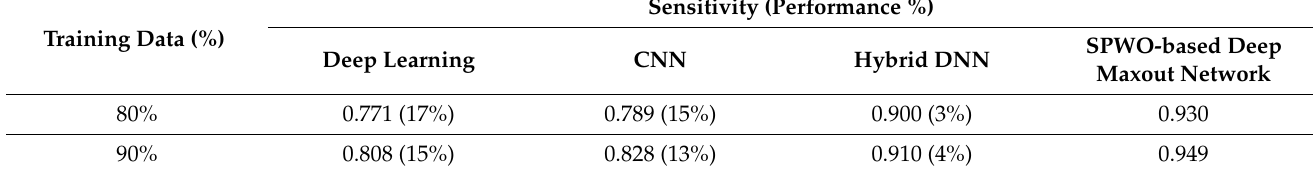
Table 9. Analysis with Sensitivity.